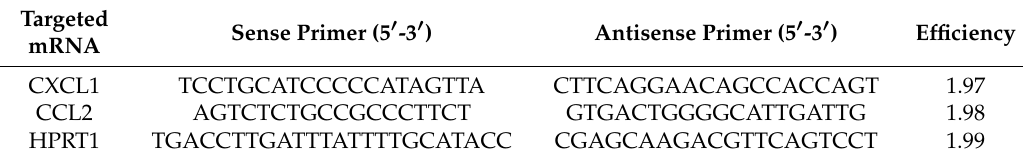
Table 3. Nucleotide sequences of primers used for RT-PCR and reaction efficiency for each Primer